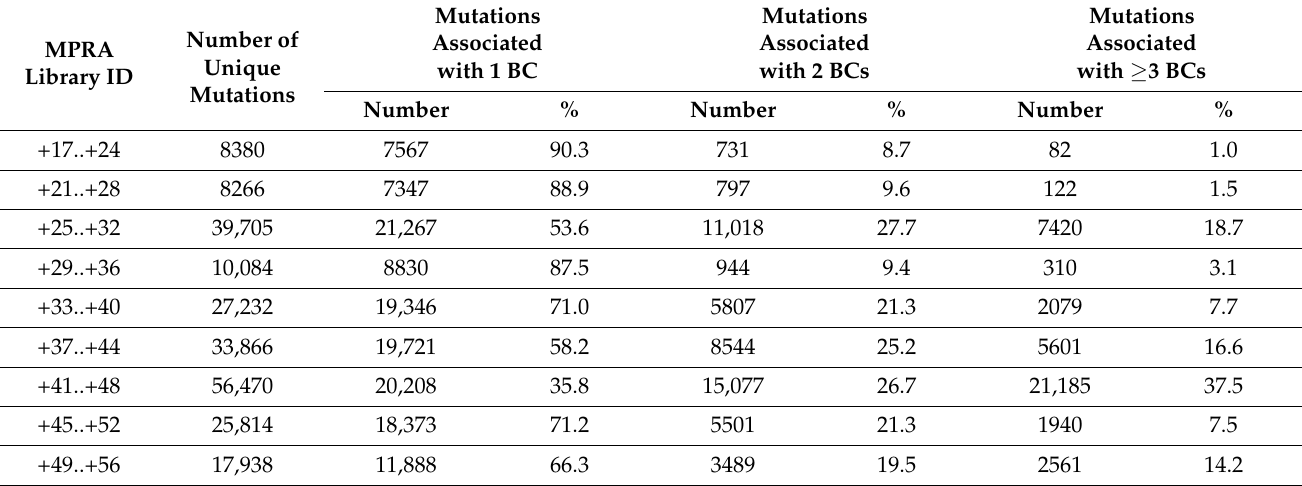
Table 1. Numbers of unique mutations and associated BCs for each MPRA library.